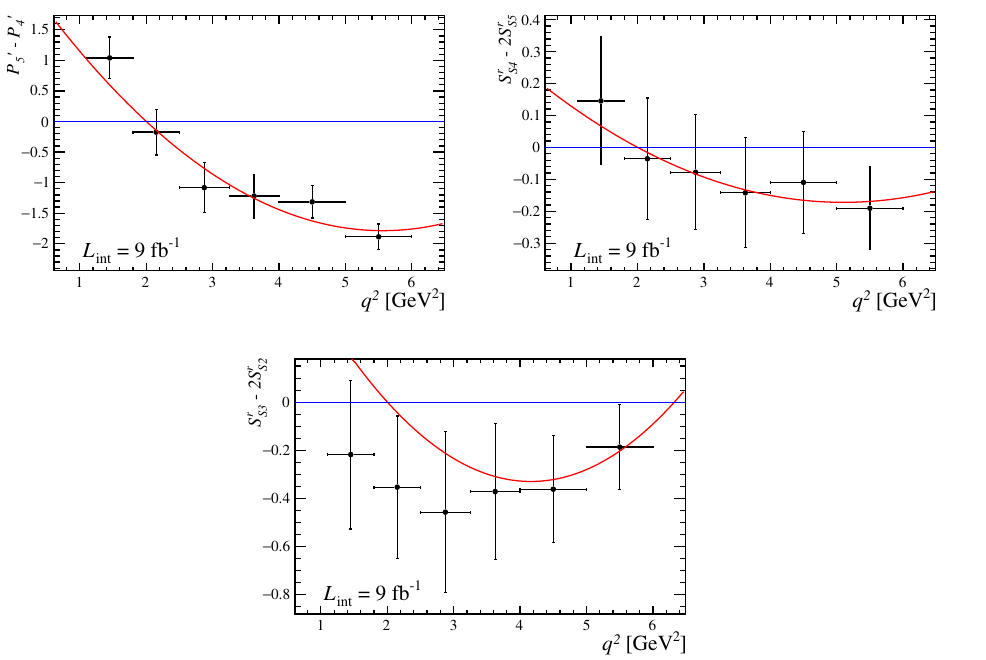
Figure 20 . Example distributions of three observables in q 2 . Overlaid in red is the result of fits of second polynomials with a common zero between the three observables. The blue line is a reference for 0. The observables are taken from pseudo-experiment fits for the estimated LHCb Run 2 yields. The value of β is taken to be